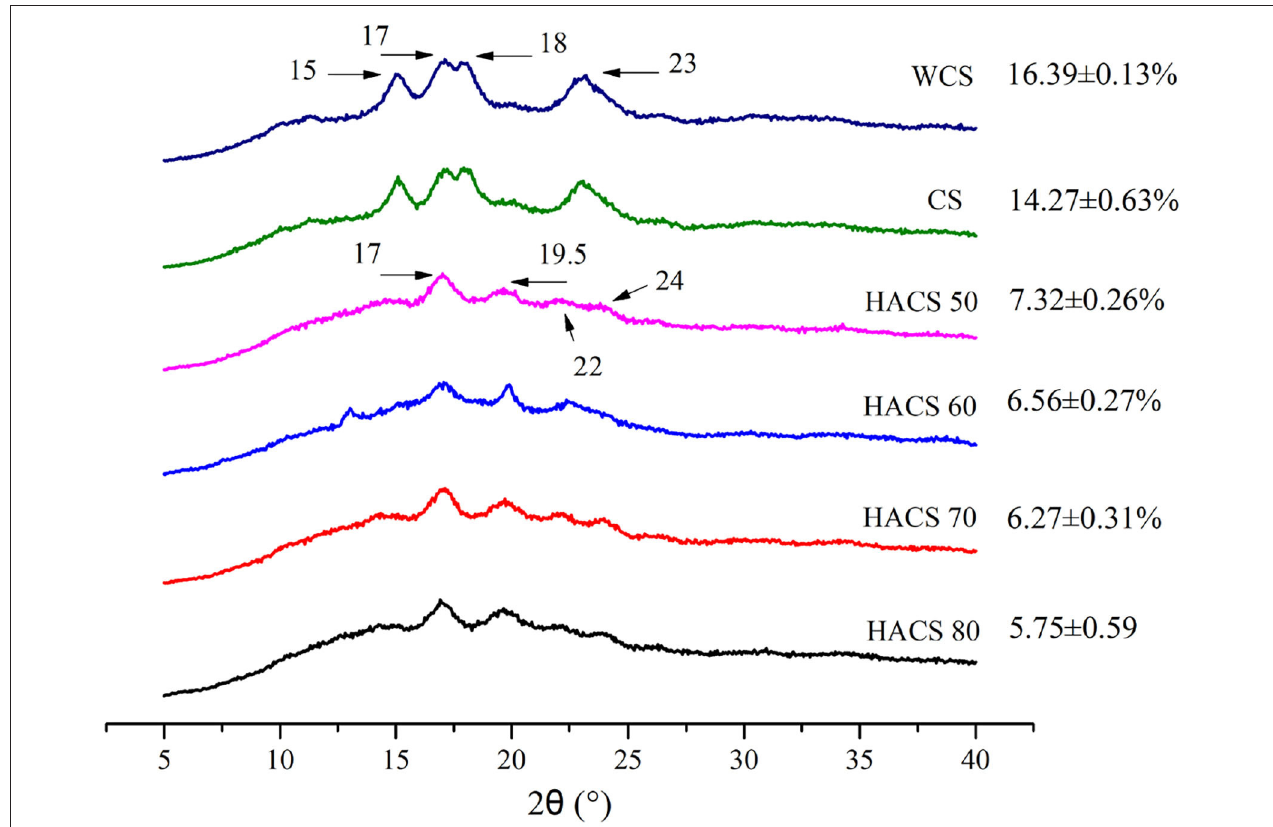
FIGURE 6 | Crystal structure of corn starch with different amylose